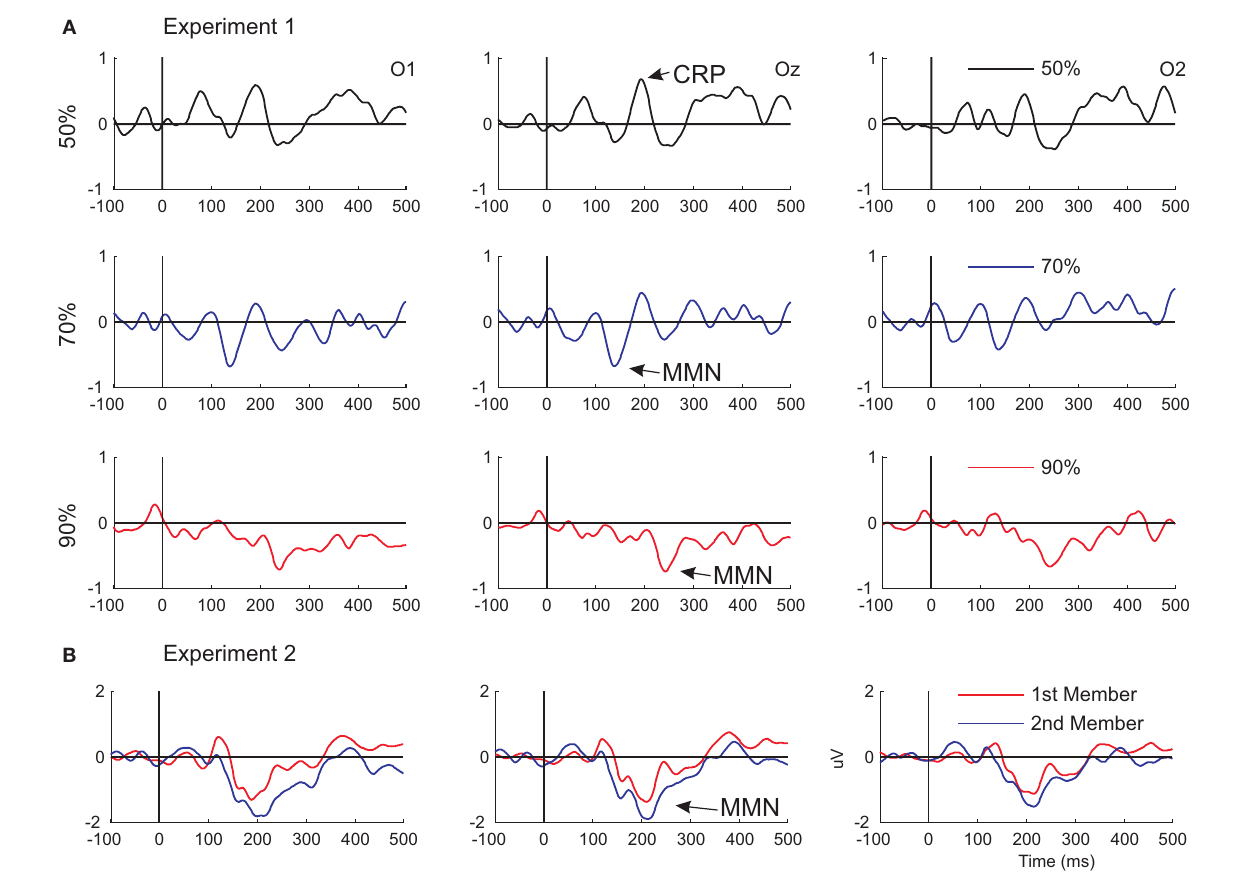
Figure 3 | Visual mismatch negativity waveforms superimposed from experiments 1 and 2. Difference waves from Experiment 1 and 2 are shown in ( A , upper panel) and ( B , lower panel),